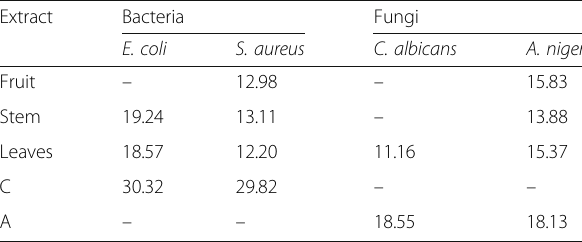
Table 2 An antimicrobial activity (diameter in mm) of Chloroform extract of parts of Helicteres isora L.